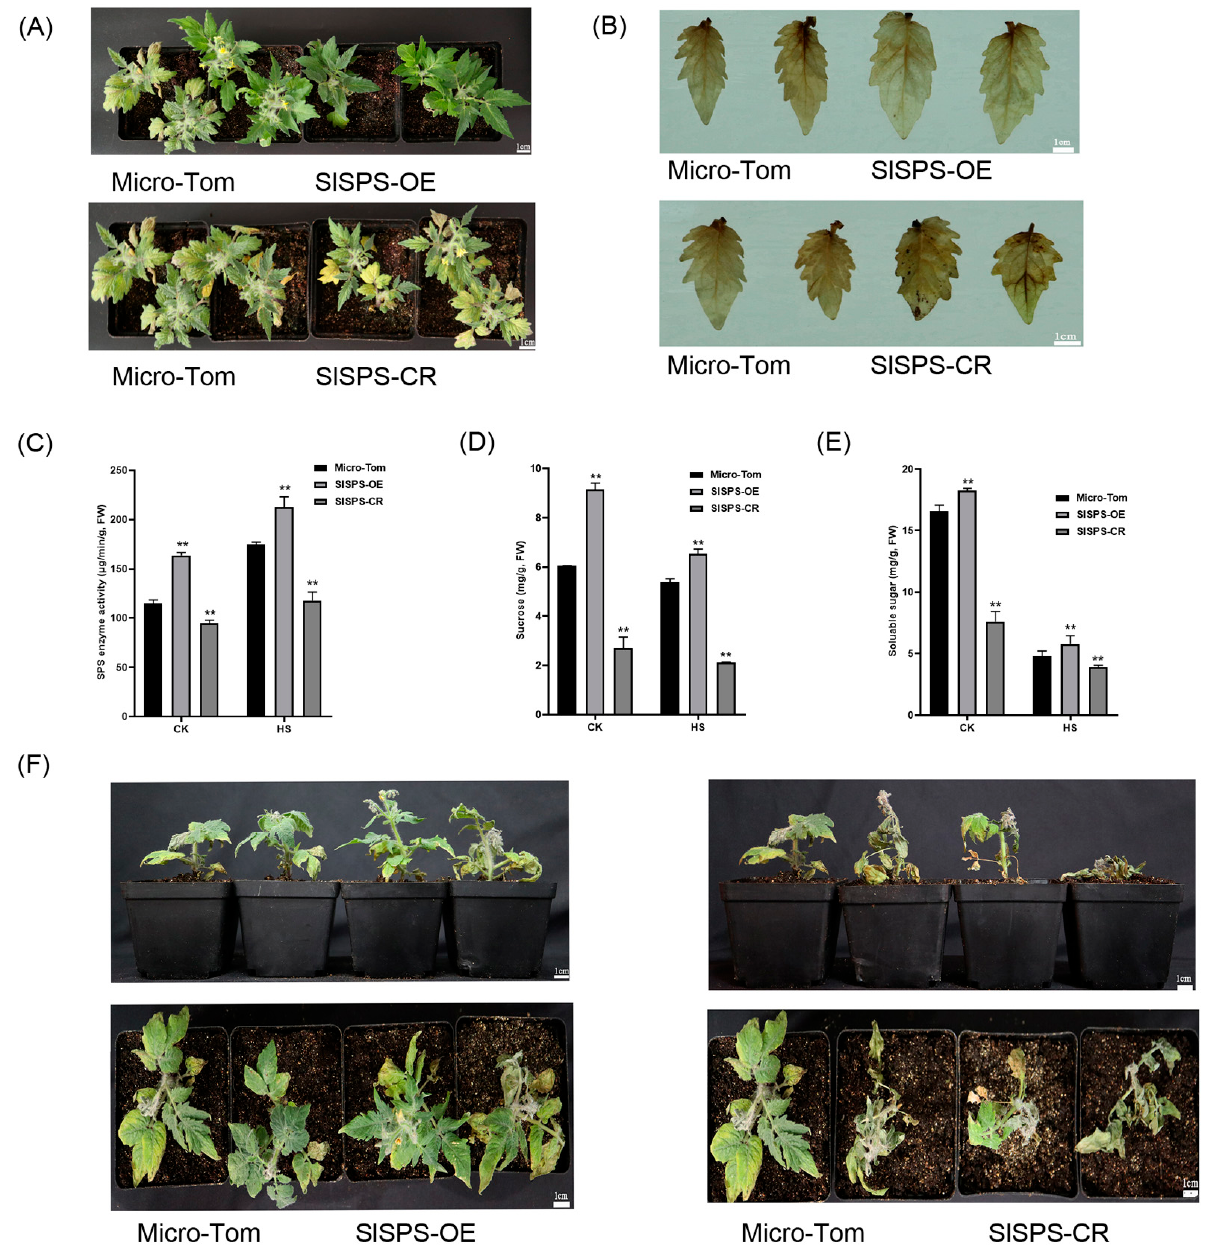
Figure 5. Seedlings of transgenic plants and Micro-Tom ( A ) and DAB staining assay results ( B ) at 96 h high temperature treatment. SPS enzyme activity ( C ), sucrose content ( D ) and soluble sugar content ( E ) at 96 h high temperature treatment. Values in ( C – E ) are means ± SD. ** p < 0.01, compar- isons with the Micro-Tom plants using Student’s t -tests. (n = 3 for each line) Seedlings of transgenic plants and Micro-Tom plants under 2-week heat stress ( F ).